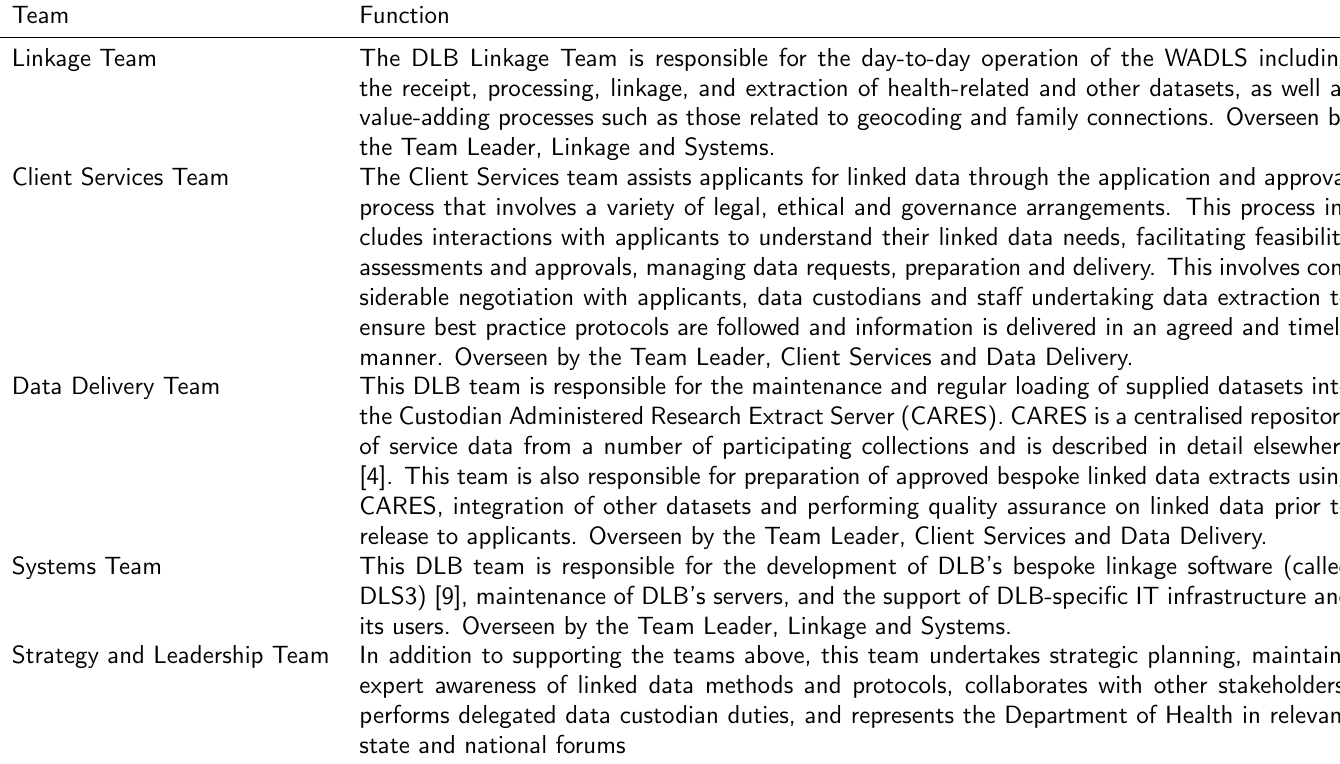
Table 1: Data Linkage Branch